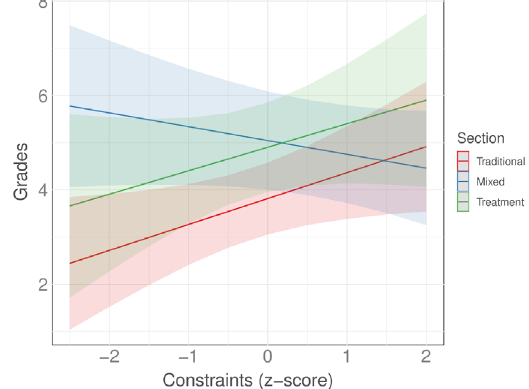
FIG. 5. Interaction between network constraint and sections for predicting physics grades.